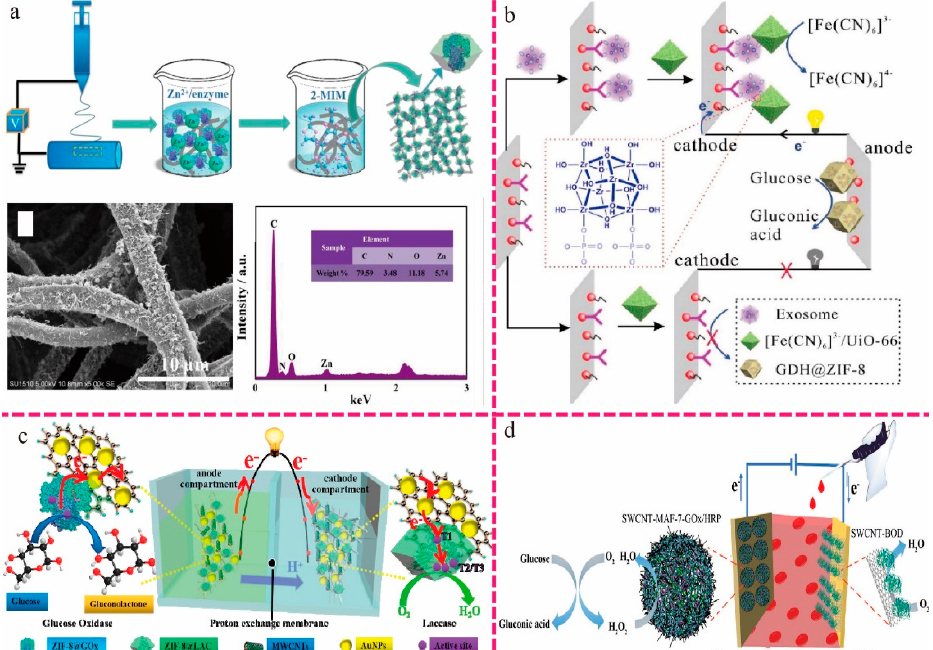
Figure 1. ( a ) Schematic diagram of PU/RC/ZIF − 8@enzyme synthesis [30]. Copyright 2022, Elsevier. ( b ) Illustration of the principle of self − powered BFC − based biosensors in the presence or absence of exosomes [31]. Copyright 2021, Elsevier. ( c ) Schematic of self − powered glucose biosensor based on EBFCs[32]. Copyright 2021, Elsevier ( d ) Schematic of the fabrication of an SWCNT and GOx/HRP coembedded MAF − 7 biocatalyst [34]. Copyright 2020, American Chemical Society.